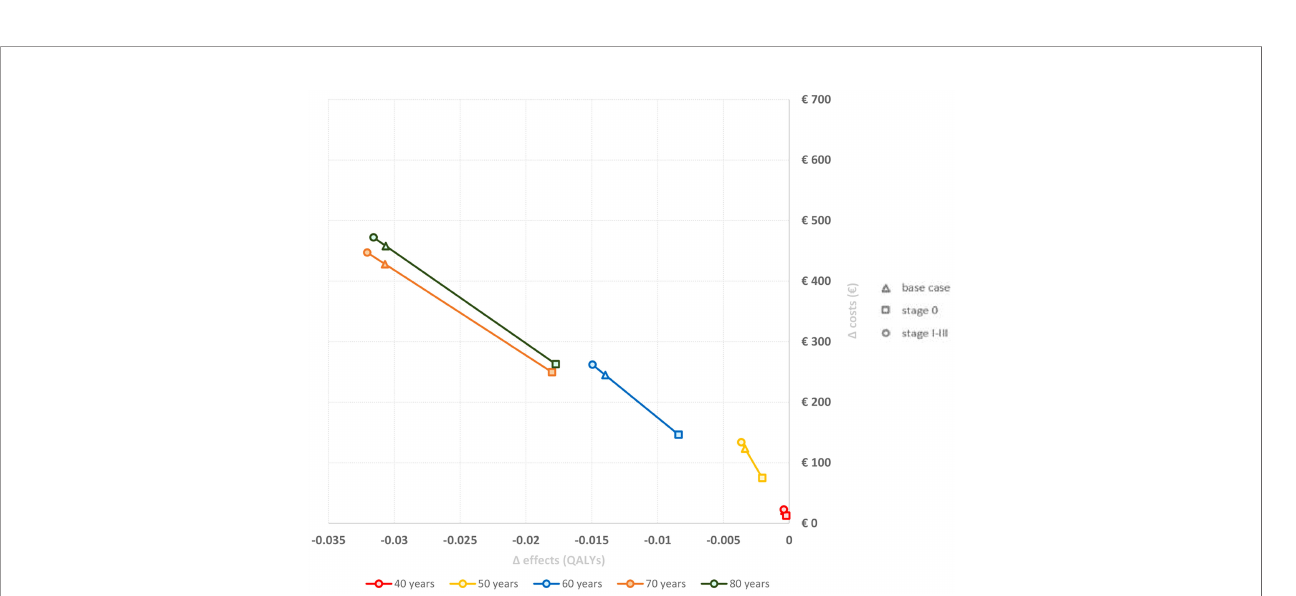
FIGURE 3 | Deterministic scenario analysis: Incremental costs and disutility by stage. The proportions of the start cohort (decision tree) were set to 0% or 100% in order to exclude either stage 0 or stage 1-3 from analysis. This resulted in various initial state cohort strati fi cations, which is indicated through different symbols. Results are presented as incremental costs and QALYs per woman for four different age groups (40 years, 50 years, 60 years, 70 years and 80 years). BC, Breast Cancer; QALYs, Quality Adjusted Life Years; y, years.